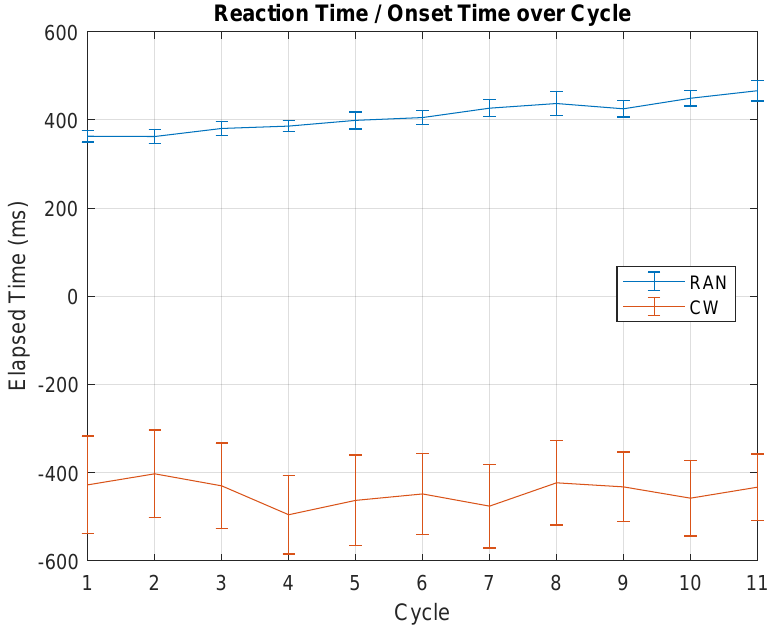
Figure 8. Reaction time (RT) and onset time (OT), over cycles, for RAN (blue) and CW (red) modes. RT is related to RAN and OT refers to CW. Since the user knows the position of the upcoming target, the movement always anticipates the target appearance; hence, OT is defined as a negative